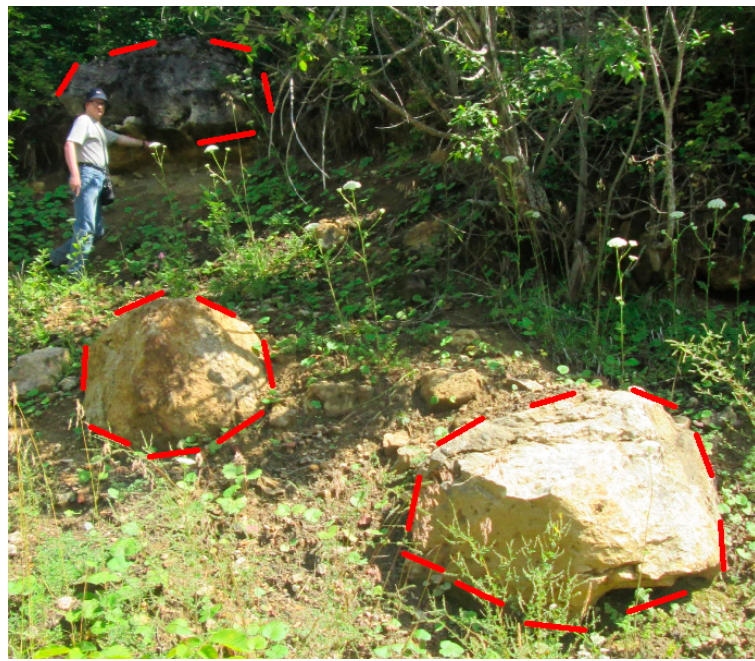
Figure 3. Large clasts (marked by red dashed line) of the Locality 2. A person is present for scale.